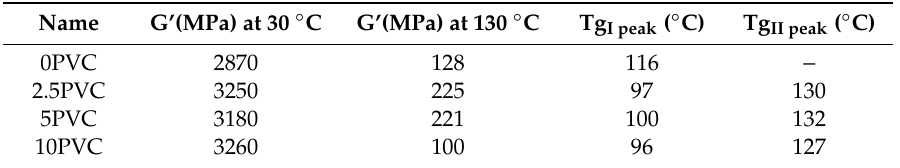
Figure 3. DMTA curves of investigated materials. Table 1. DMTA analysis